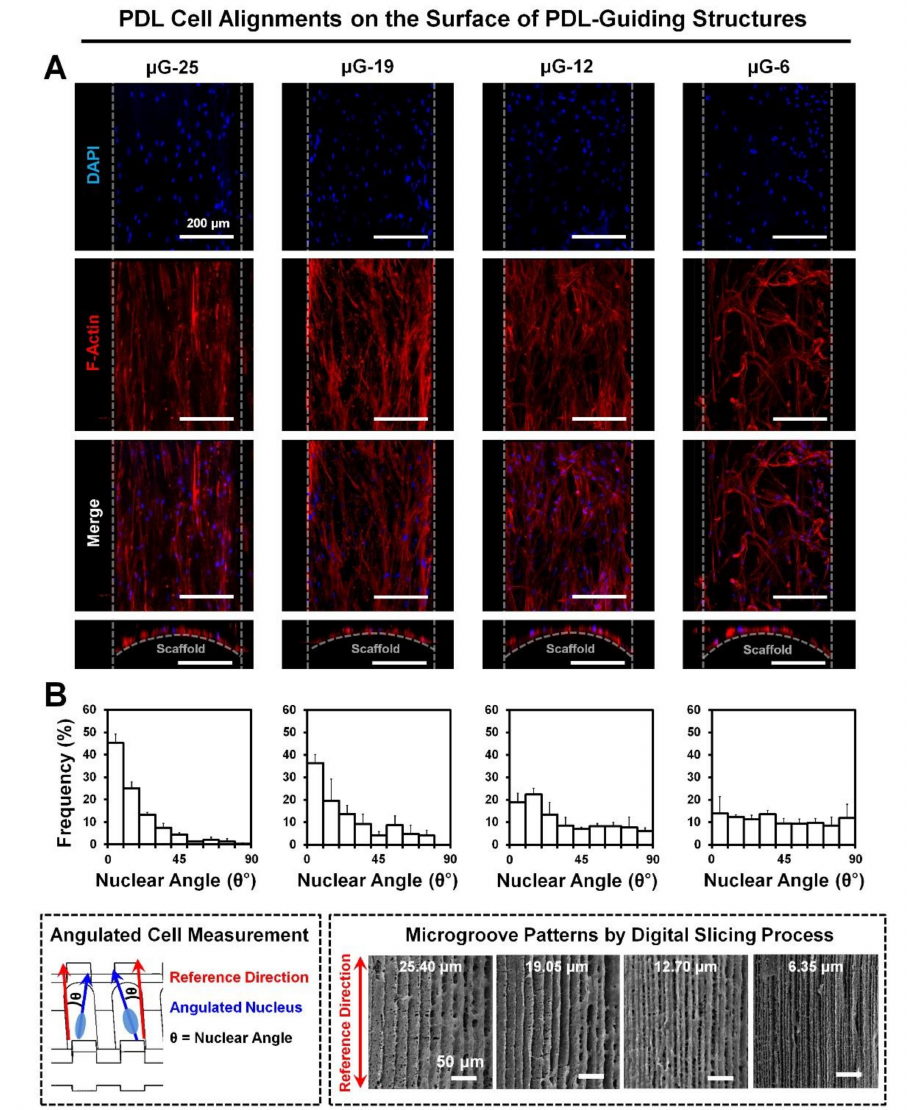
Figure 3. Cell orientations and angulations were analyzed using the fluorescence staining method with cell nuclei and actin filaments. ( A ) Cytoskeleton polarities or cell orientations to the reference direction can be qualitatively determined based on the actin filament staining for 7-day cultures. ( B ) Nuclear angulations were measured using directionalities of the 4 (cid:48) ,6-diamidino-2-phenylindole (DAPI) stained cell nuclei and distributions of nuclei were defined with the statistical quantification. White dash-lines represent the ligament architecture border lines with a 250- µ m distance. Scale bars: 200 µ